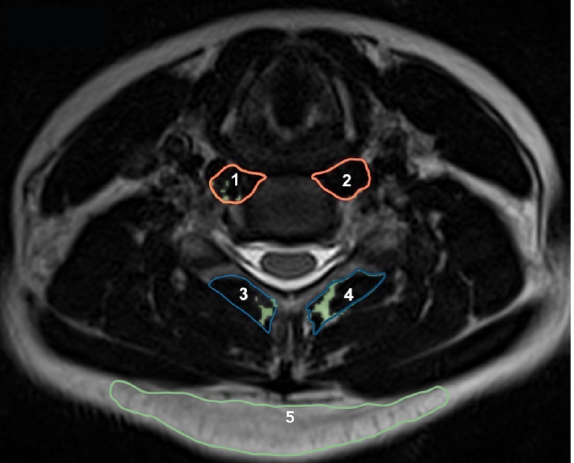
Figure 2. Measurement of cross-sectional area of the longus colli (1 and 2), multifidus (3 and 4), fat of posterior subcutaneous (5), and muscle fat infiltration (in green) at the C5-C6 level. Multifidus and longus colli muscle volumes were calculated by a 3D multiplanar re- construction of the muscles using Osirix (Figure 3) [45]. They were based on CSA meas- urements obtained on each slice every 3 mm from C4 to C7 for the multifidus and from C3 to C7 for the longus colli muscle. Fat-free muscle volume of longus colli (rVOL-Colli, ( b ) Figure 3. A three-dimensional multiplanar reconstruction of the multifidus muscle ( a ) and fat infil- tration of the multifidus muscle ( b ).